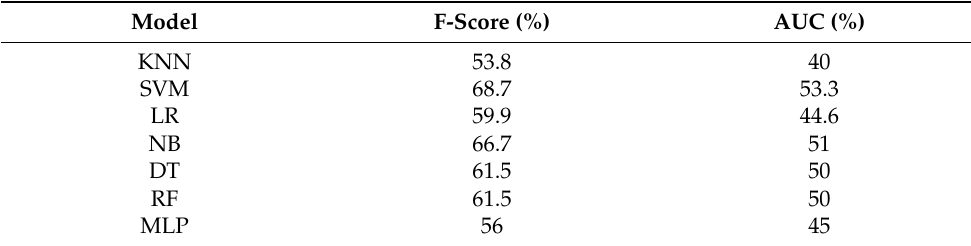
Table 6. Algorithmic performance for ‘StockTwits with TextBlob’ dataset.